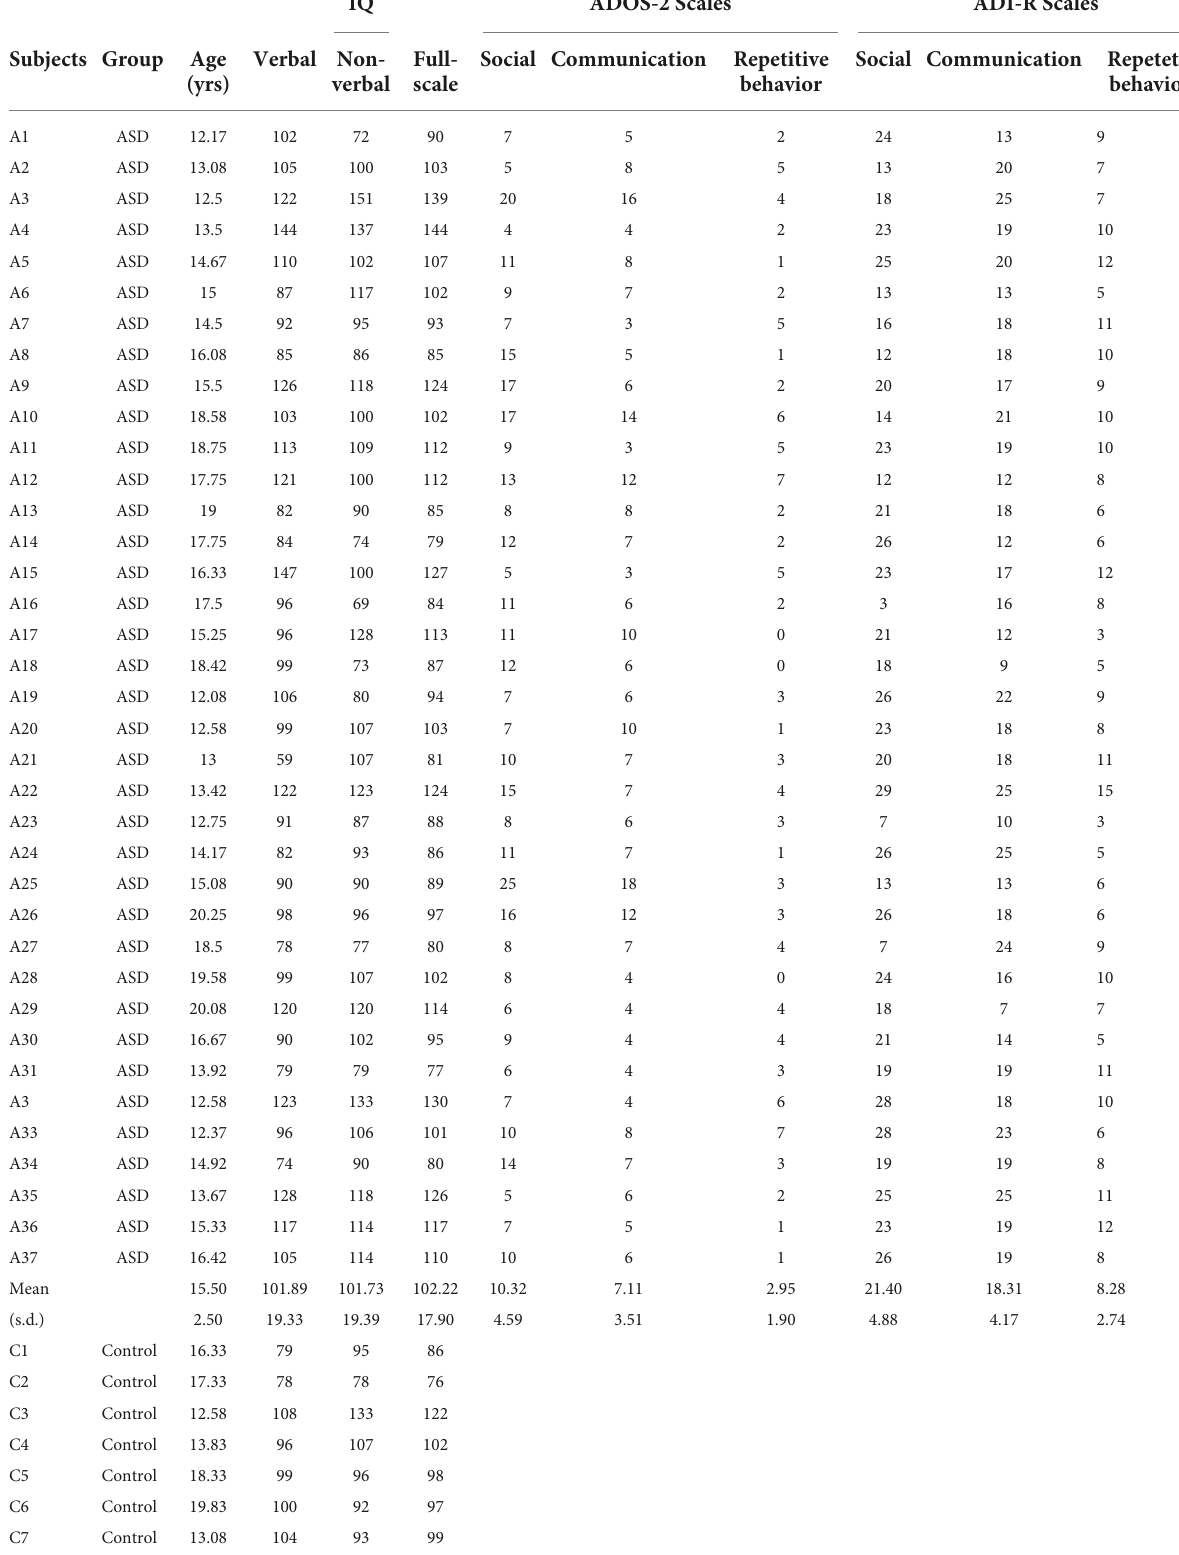
TABLE 1 Characteristics of ASD group and control group (IQ, ADOS, ADI-R). IQ ADOS-2 Scales ADI-R